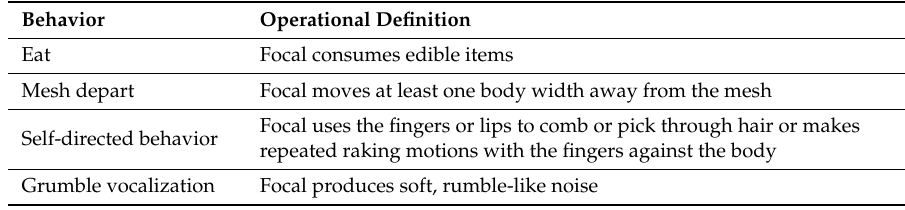
Table 1. Gorilla ethogram for all-occurrence behaviors.